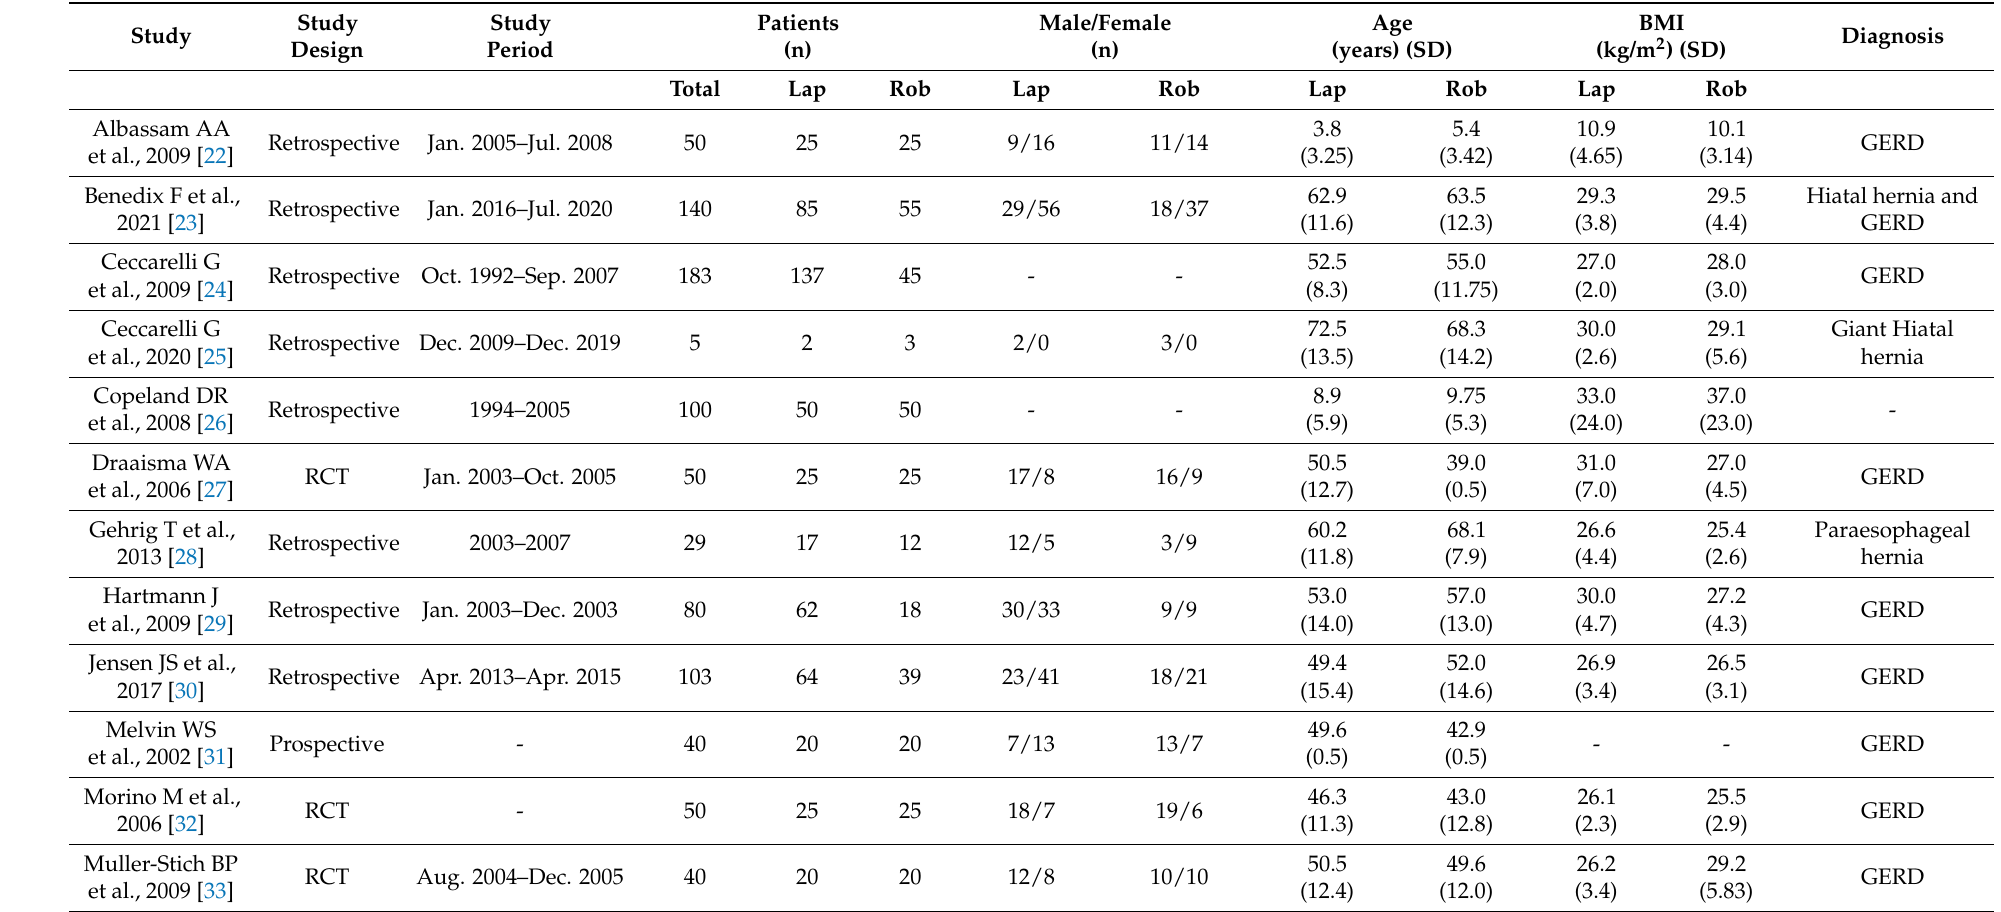
Table 1. Baseline characteristics of the included